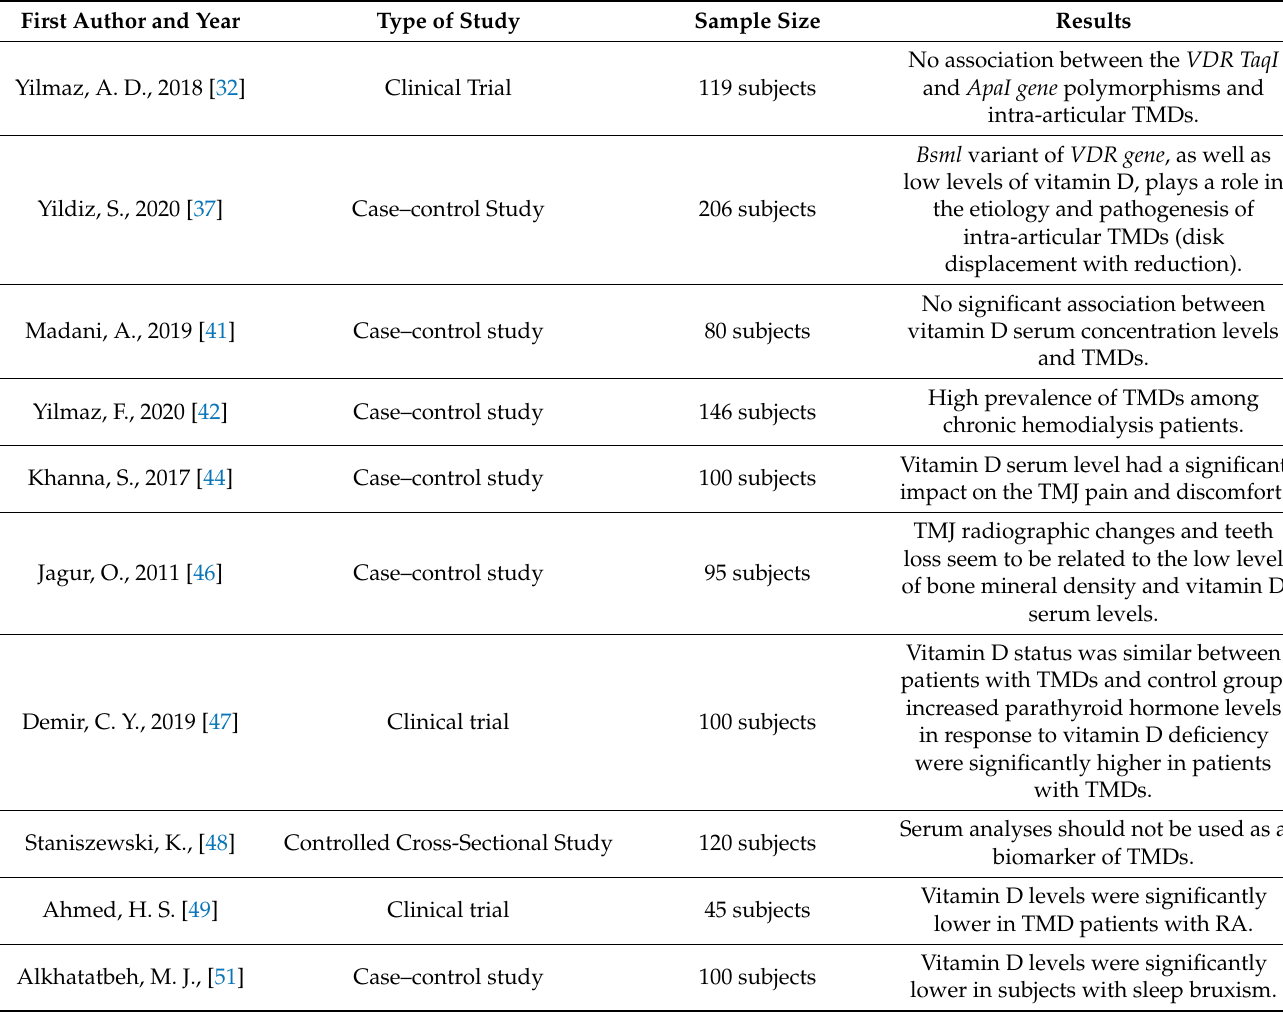
Table 3. Overview of the articles investigating an association between different types of temporomandibular disorders and low level of vitamin